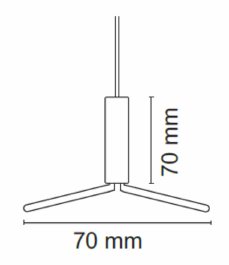
Figure 1. Sketch of the Brand 2 Vaginal Implant Transmitter (VIT) size